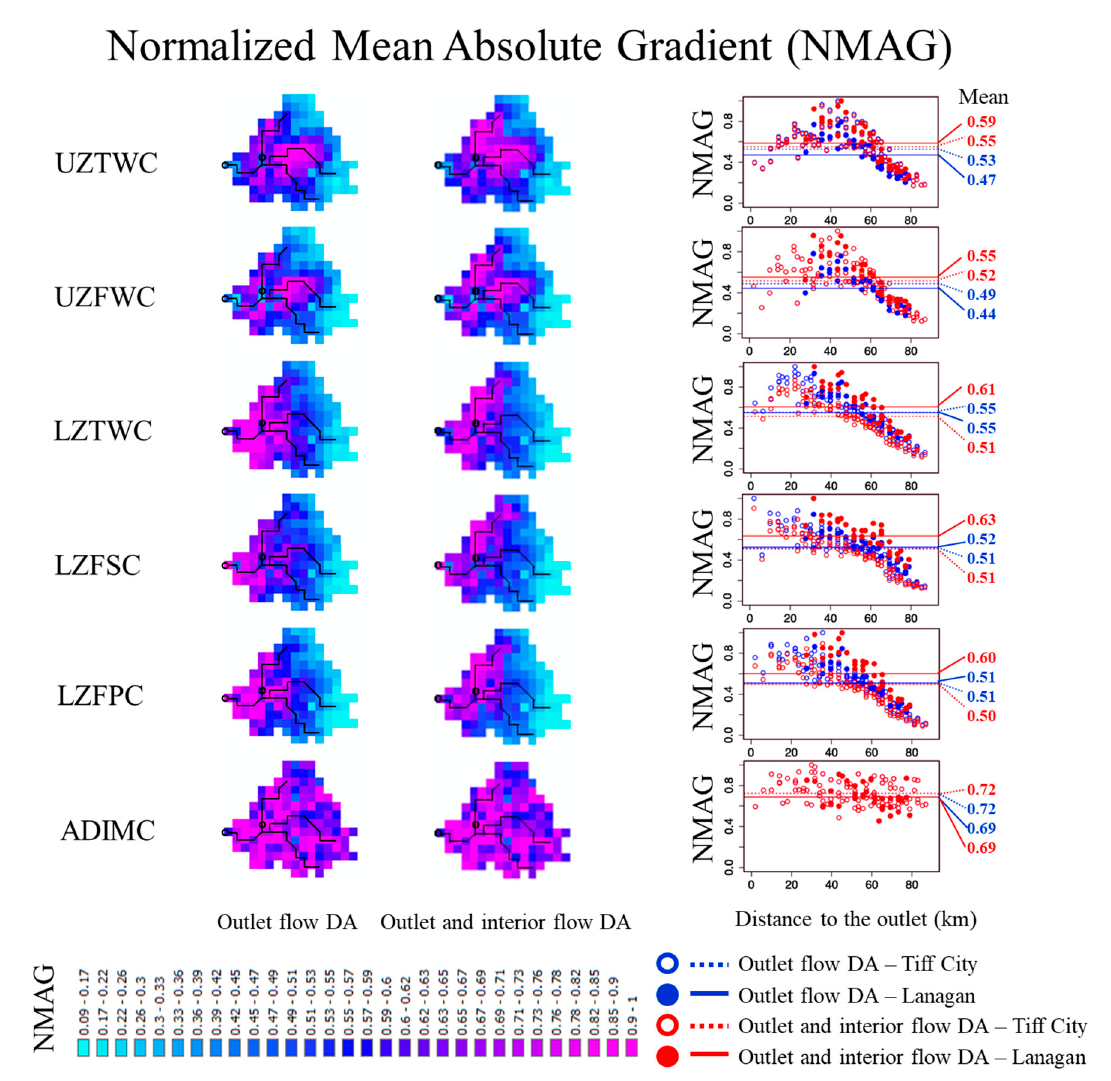
Figure 3. Time-averaged, normalized absolute gradient values of the objective function (Equation (15)) with respect to individual model states, or NMAG in Equation (21), evaluated at each HRAP cell. The largest gradient value for UZTWC, UZFWC, LZTWC, LZSFC, LZPFC, and ADIMC are 85 (86), 11 (11), 261 (301), 9 (10), 52 (58) and 0.00005 (0.00005) (mm − 1 ) in the case of assimilating outlet flow (outlet and interior flow).